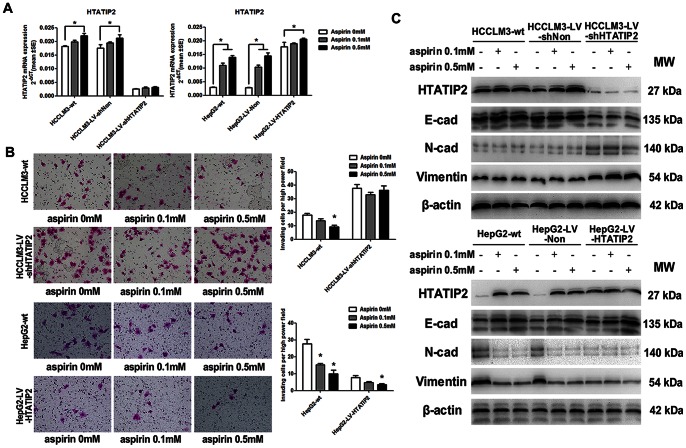
Up-regulation of HTATIP2 by aspirin reversed epithelial-to-mesenchymal transition (EMT) and inhibited invasion in HCC cell lines.(A) Expression of HTATIP2 mRNA was detected by RT-PCR (columns, mean of 6 samples in each group; bars, SEM; *, P<0.05). (B) Invasion of HCC cell lines with different expression levels of HTATIP2 was measured by transwell assay. Left panel: migrated tumor cells. Right panel: quantification of invasion assay. (C) Levels of HTATIP2 protein and EMT markers, including E-cadherin, N-cadherin, and vimentin, were revealed by Western blotting.